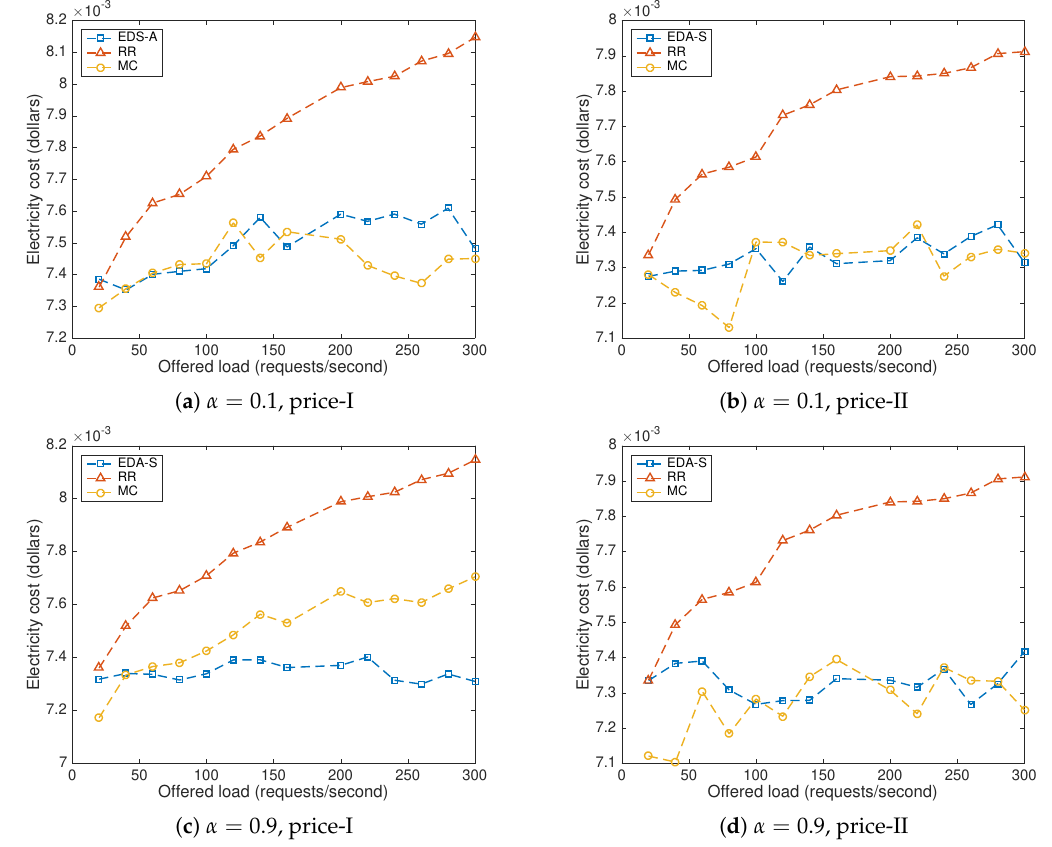
Figure 8. Electricity cost with CA-S tested in